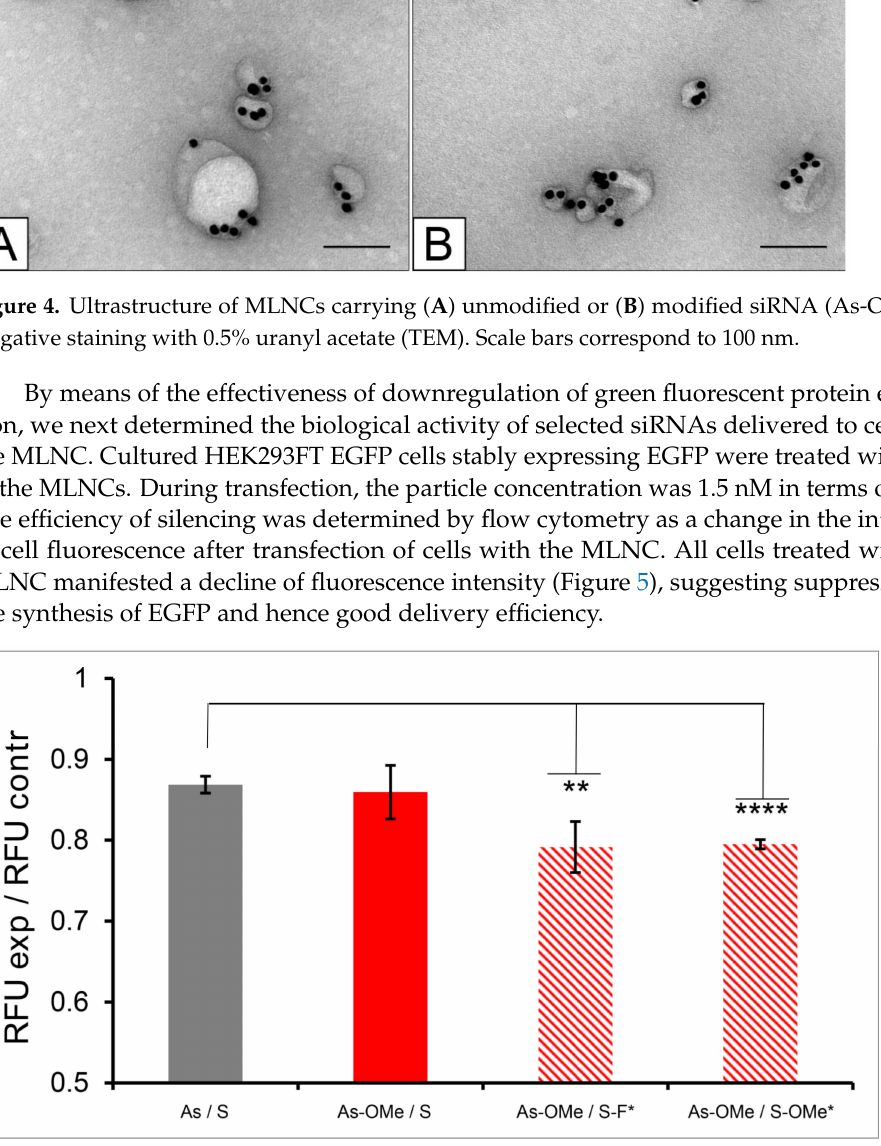
Figure 5. The normalized mean value of cell fluorescence (RFUexp/RFUcontr) after incubation of HEK293FT EGFP cells with one of MLNCs. Striped columns denote PG-modified siRNAs, and an asterisk (*) in an siRNA name means the PG-modified strand. Data were obtained by flow cytometry. At least 10,000 events were acquired in each sample; mean values ( ± SD) from three independent experiments are presented. The data were statistically assessed by one-way ANOVA. Significant differences between cell groups: ** p < 0.05; **** p < 0.0005. RFU: relative fluorescence